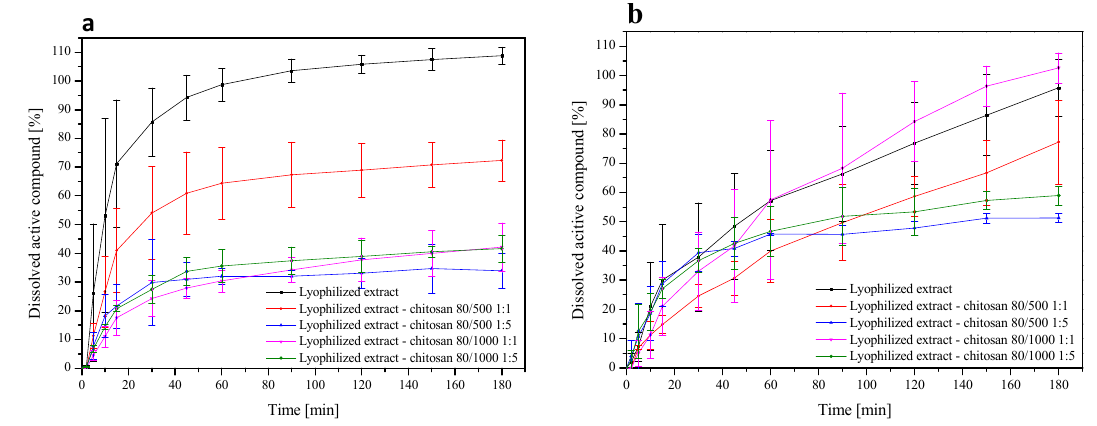
Figure 3. Dissolution profiles of the chelidonine ( A ) and the sanguinarine ( B ) from Chelidonii herba lyophilized extract at its chitosan delivery systems at pH ~4.5.